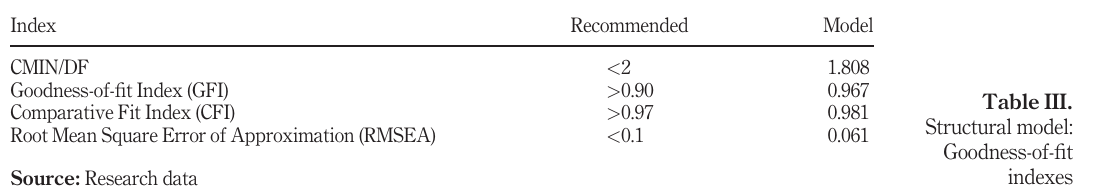
Table III. Structural